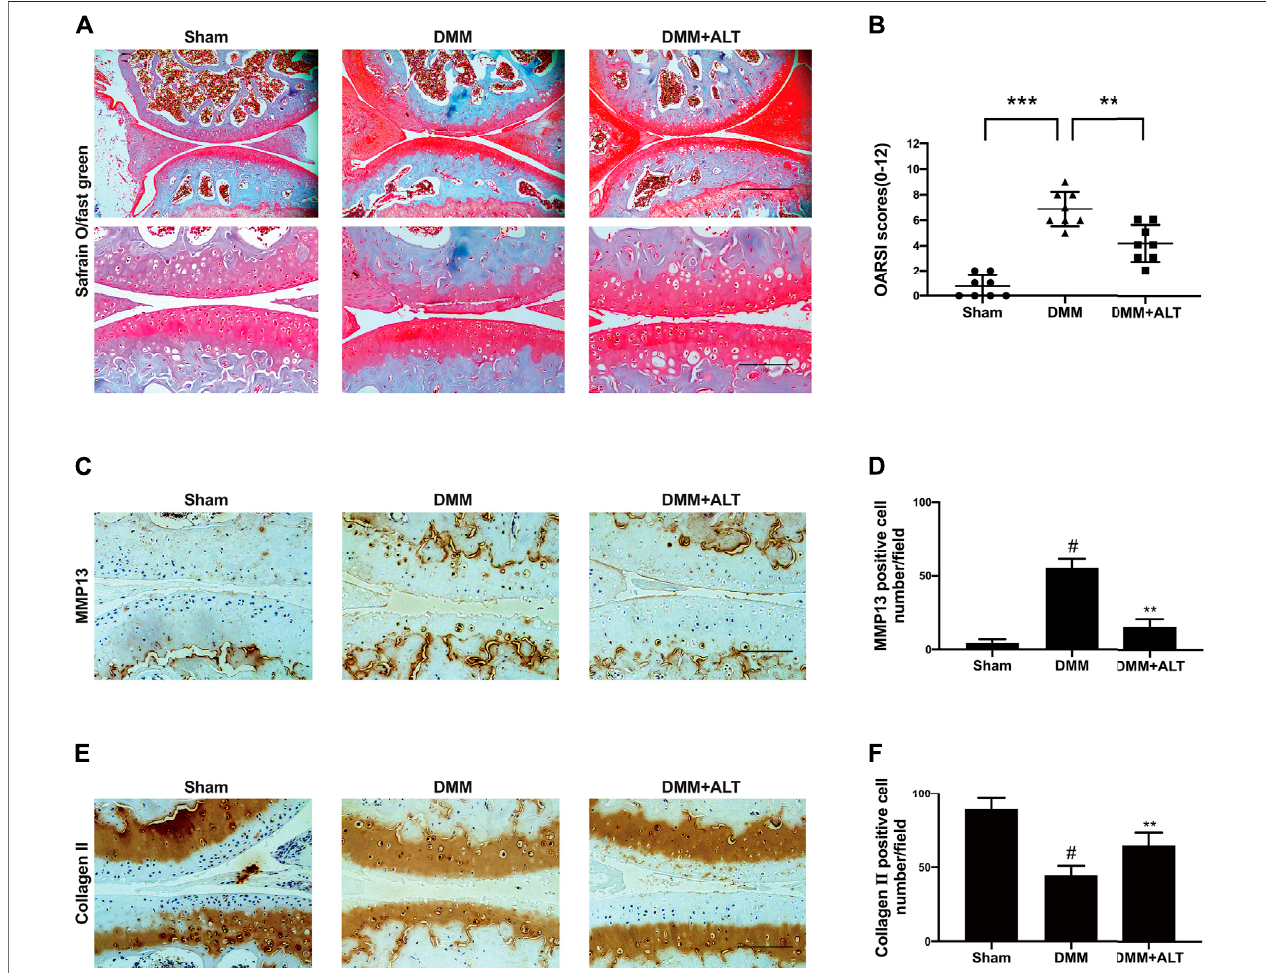
FIGURE9| ALTattenuatedthevitiationofcartilageonthemouseOAmodel. (A) MicroscopicphotosofSafranin-O-Fastgreenstainedmousekneejointsectionsof three groups (scale bar 200 and 100 μ m). (B) The OARSI scores of each group. ** p < 0.01; *** p < 0.001 (C) Immunohistochemistry staining of MMP13. (D) Number of MMP13positivecellsper fi eldunder100-timemagni fi cation. (E) ImmunohistochemistrystainingofCollagenII. (F) NumberofCollagenIIpositivecellsper fi eldunder100- time magni fi cation. # p < 0.05 vs. sham group; ** p < 0.01 vs. DMM group.